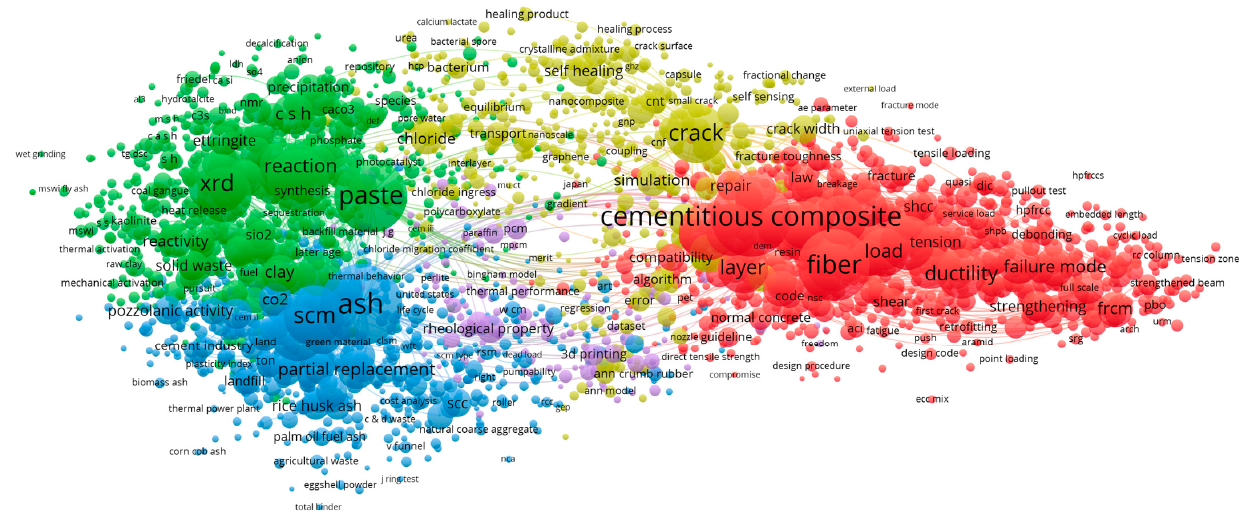
Figure 2. Map of related topics—cementitious materials.